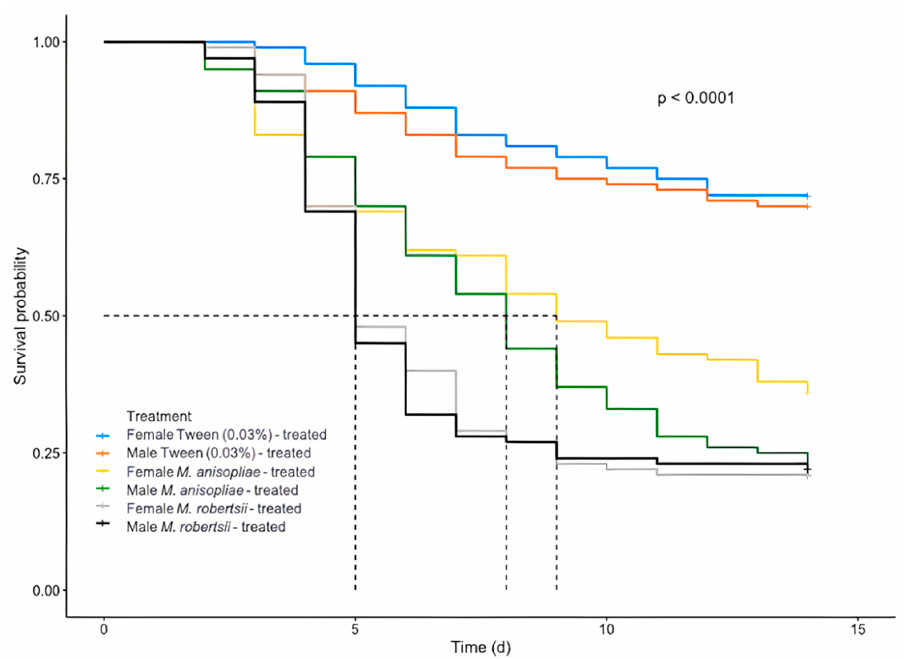
Figure 1. Survival of male and female Diachasmimorpha longicaudata adults treated with conidia of Metarhizium robertsii V3-160 and Metarhizium anisopliae MAAP1. Solid lines represent the cumulative survival curves of the Kaplan ‐ Meier analysis and dashed lines indicate the median survival days. Table 1. Mortality (Abbott correction % values), and germination and sporulation rates (±SD) of Metarhizium robertsii V3 ‐ 160 and Metarhizium anisopliae MAAP1 from Anastrepha ludens larvae par ‐ asitized or non ‐ parasitized by Diachasmimorpha longicaudata .